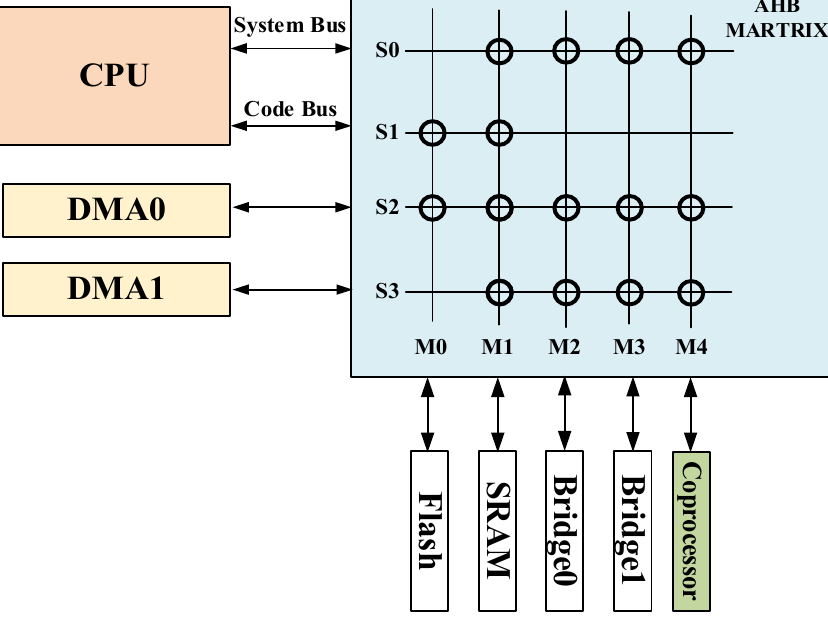
Figure 13. Bus interconnection.